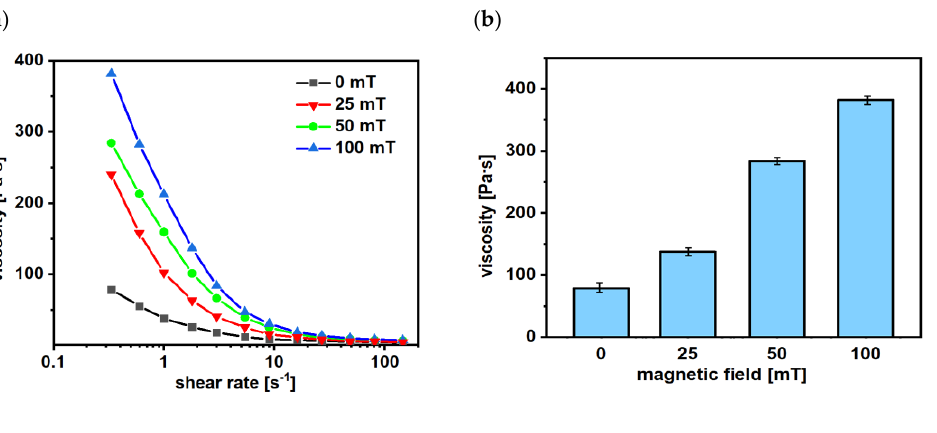
11 of 17 Figure 7. ( a ) Thermogravimetric curve of the MRF, and ( b ) the MRF attracted by the magnet and collected at the bottom of the beaker. 2.7. Viscosity Measurements In order to define the rheological properties of prepared MRF the viscosity change under the magnetic field was investigated. The MRFs were examined using a rotating rheometer (Rheotest 2.1, Germany) that was dedicated to performing experiments under the external magnetic field. As can be seen in Figure 8a, the MRF is thickening with the increase in the magnetic field. The shear thinning is observed, and almost all MRFs